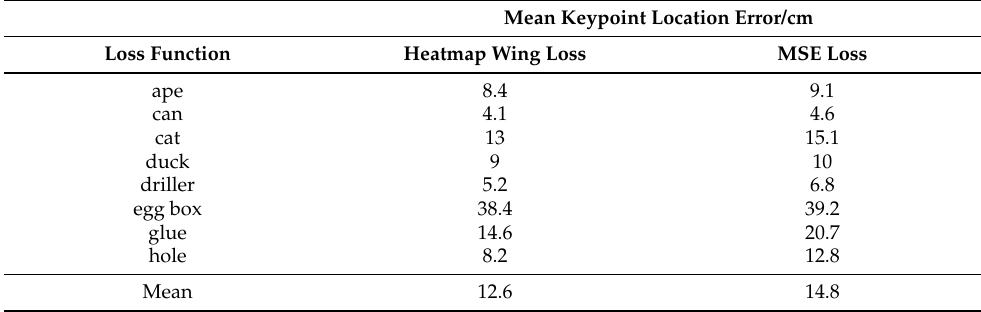
Table 2. Comparison of mean keypoint location errors on the Occlusion LINEMOD dataset of algorithms trained with different loss functions.